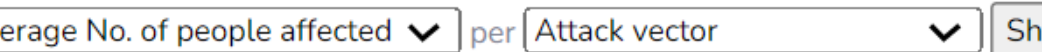
Figure 4. The graph generator menu.